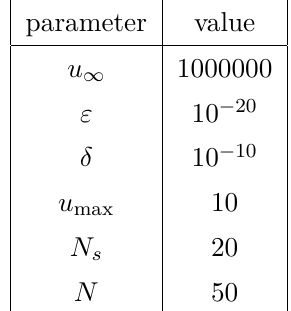
Table 3 . A table of numerical parameters